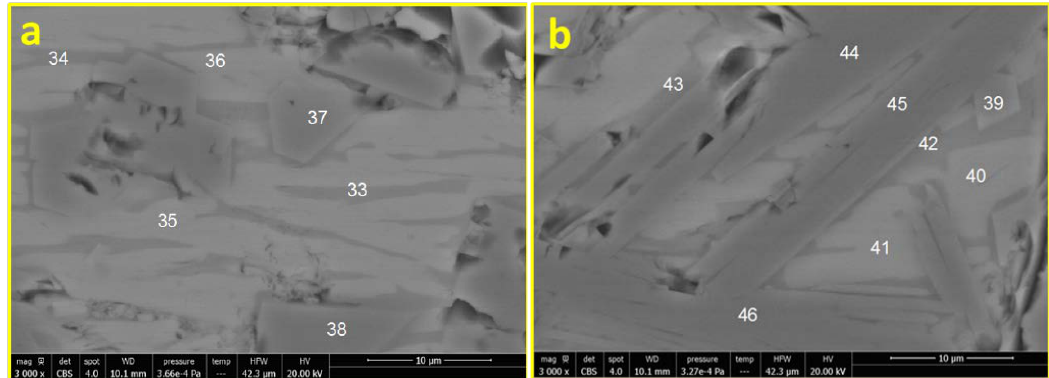
Figure 8. Microstructure of MagA-gun at the hot side.